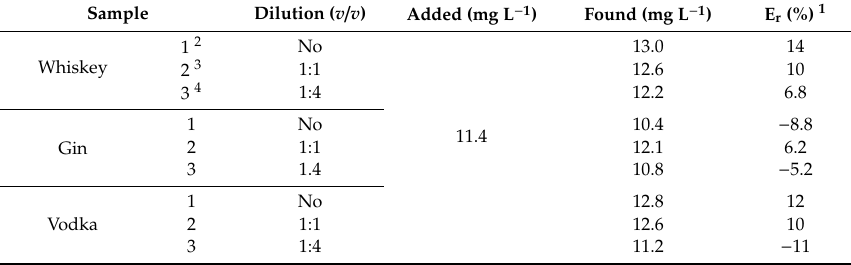
Figure 4. CVs for the determination of flunitrazepam using the reduction peak R 2 in: ( Α ) gin, (( B ) vodka) and, ( C ) whiskey samples diluted 1:1 ( v / v ), (a) before and (b) after spiking with 11.4 mg L − 1 of flunitrazepam. Table 2. Accuracy for the determination of flunitrazepam in individual spirits using the reduction peak R 2 . Sample Dilution ( v / v